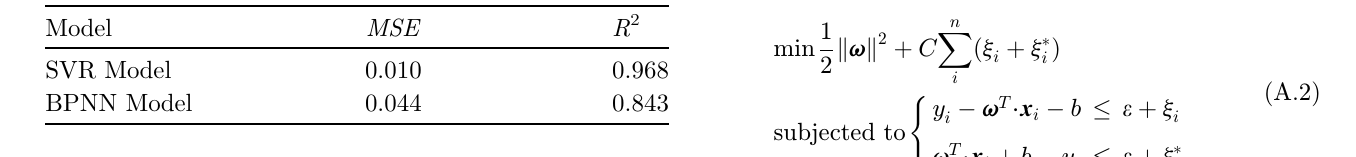
Table 3. The MSE and R 2 values of the SVR and BPNN model on testing